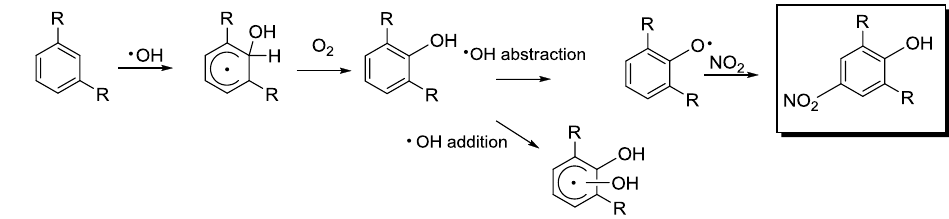
Figure 1. Reaction scheme of proposed mechanism of the gas phase formation pathway of the target compounds from aromatic VOCs. Here, the R represents either a hydrogen atom or a methyl group (adapted from Forstner et al., 1997).